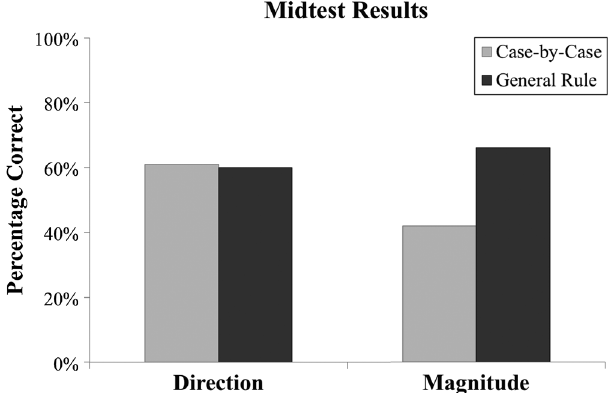
FIG. 7. Correctness on the direction and magnitude midtest questions. Between the CC and GR conditions, there is no difference on the direction question, but an advantage of GR on the magnitude question.